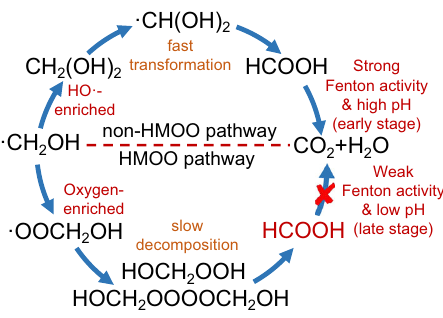
Fig. 7 Schematic illustration of the pathway regulation. Scheme of the proposed HMOO and non-HMOO pathways for ·CH 2